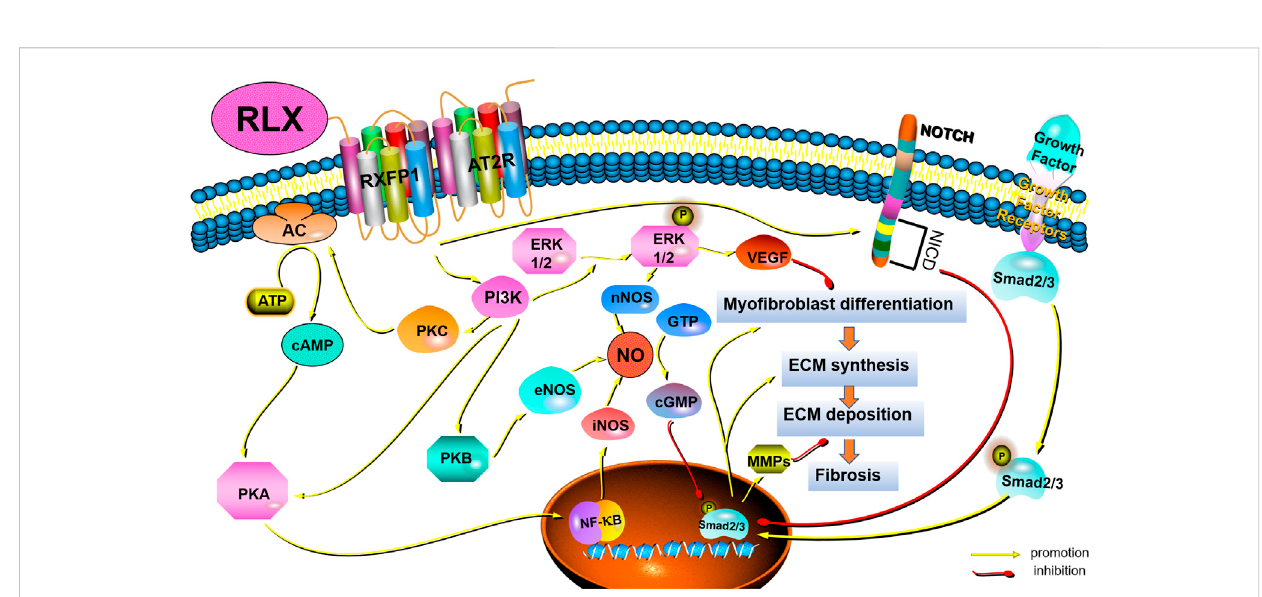
FIGURE 2 Schematic drawing of the main anti- fi brotic signaling transduction mechanisms of RLX/RXFP1.